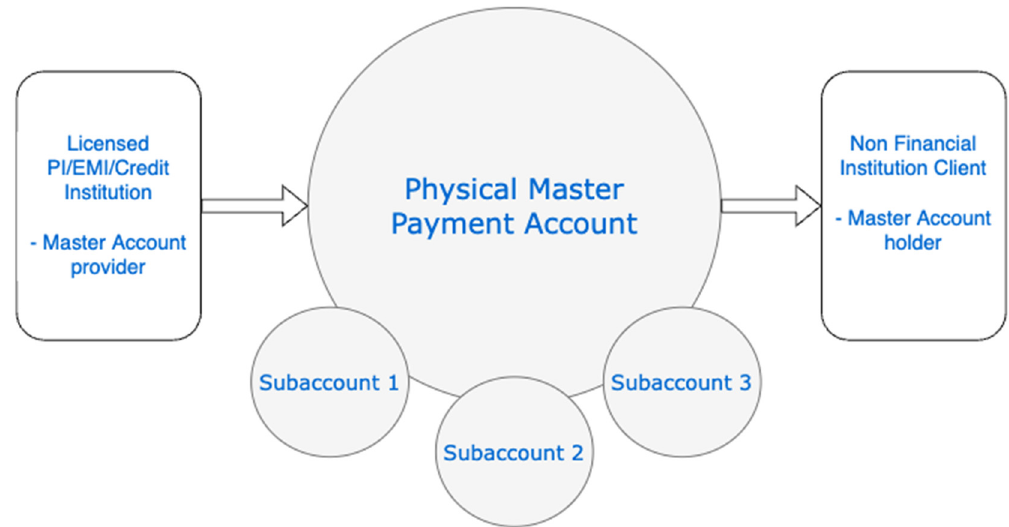
Figure 1. Mass payment accounts.